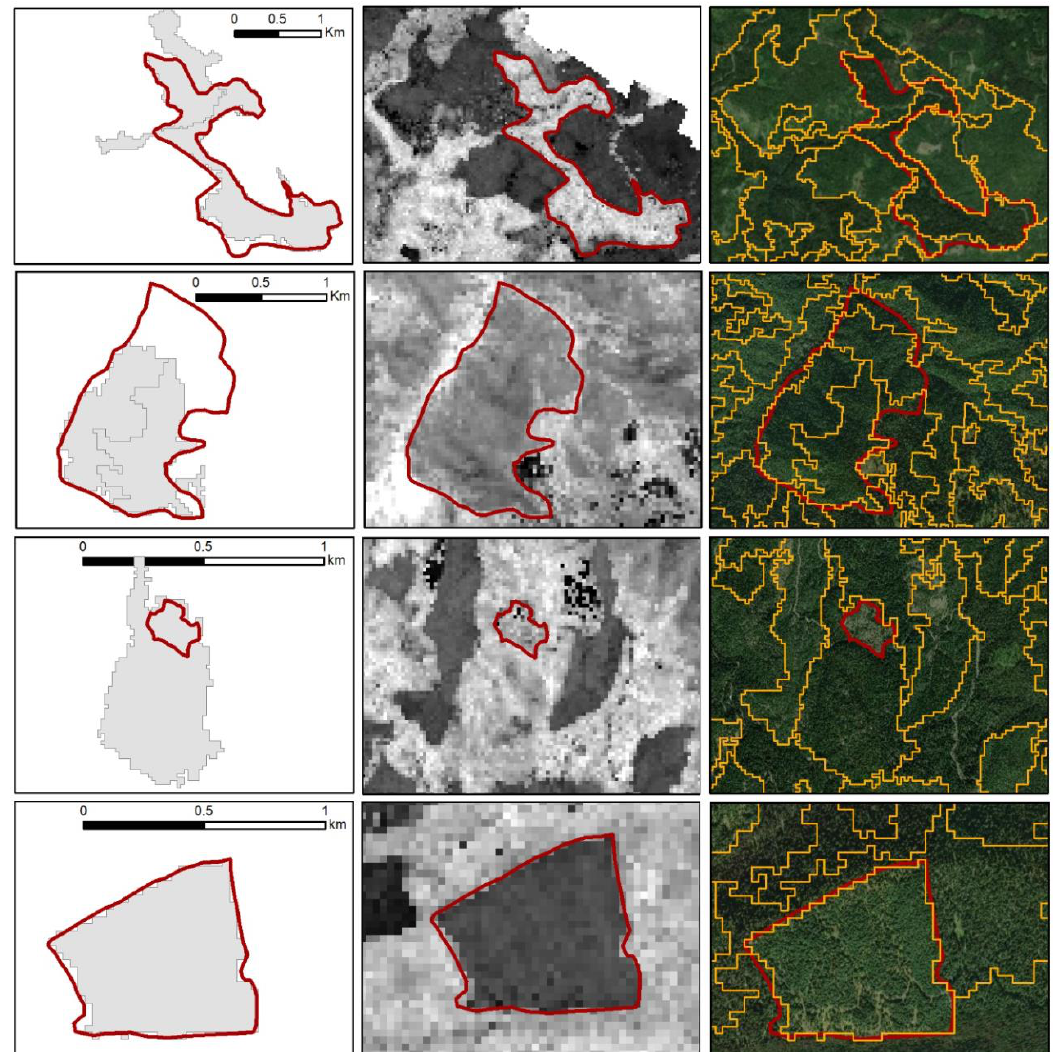
Figure 11. Illustrative examples of the spatial relationship between visually interpreted reference objects and corresponding image objects of the optimal segmentation of the ‘H95′ LiDAR metric. The two top rows present examples of uneven-aged forest stands (UAF), and the two bottom rows present examples of even-aged forest stands (EAF). Left column: Reference objects (red polygons) and set of the corresponding image objects (gray polygons). Center column: Reference objects overlaid on the ‘H95′ LiDAR metric shown in grayscale. Right column: Reference object and all image objects (orange polygons) overlaid on 1 m spatial resolution NAIP imagery used to generate the validation dataset, shown in true color.